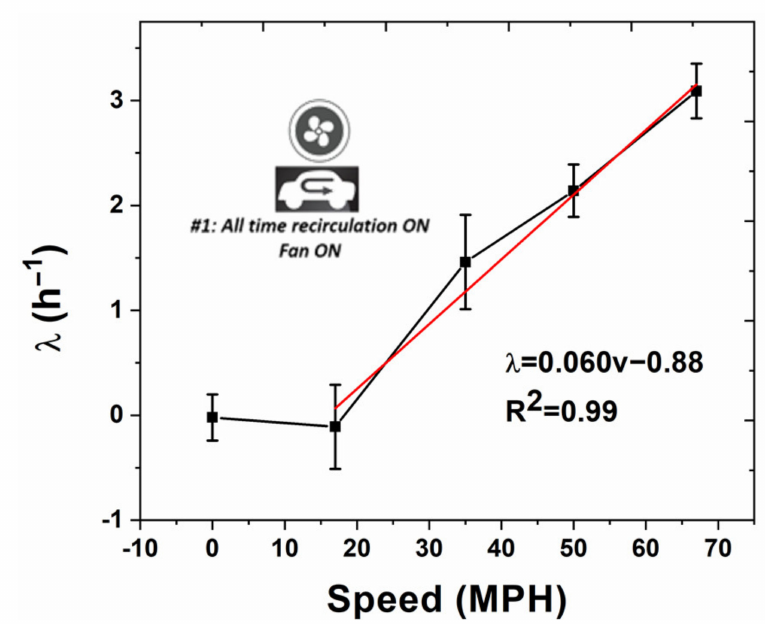
Figure 3. Relationship between the e ff ective air exchange rate ( λ ) and driving speed ( ν ). Red line indicates linear regression curve above 17